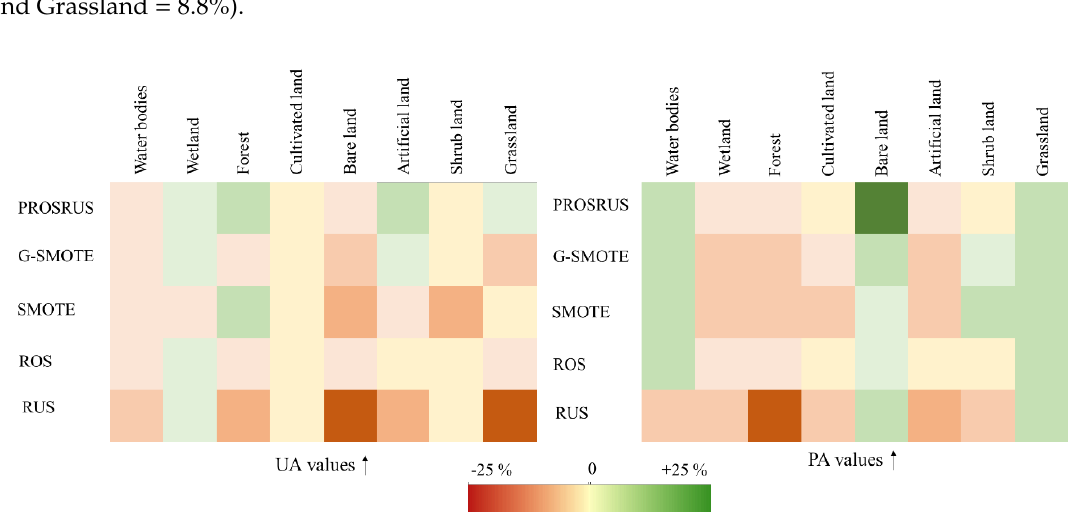
Figure 10. Accuracy assessment of the five resampling methods and the Scenario-4 classification method (i.e., RF with imbalanced samples) over Site-3. Applying PROSRUS-74 led to an increase in the UA values for four classes (out of eight), including Grassland, Bare land, Forest, and Artificial land classes by 5%, 1.3%, 2.7%, and 6.8%, respectively. However, it decreased the accuracy of the Shrub land ( − 0.4) and Cultivated land ( − 2.2%) classes. RF-G-SMOTE, respectively, increased the UA values for the Forest, Cultivated land, Bare land, and Grassland classes approximately by 2%, 0.1%, 2.1%, and 3.38%. It however decreased the PA values of the other three classes. Regarding PA values, PROSRUS-74 improved the results of five classes compared to the Scenario-4 (Shrub land = 23%, Bare land = 2.4%, Cultivated land = 1.5%, Grassland = 1.5%, and Artificial land = 0.01%) (Figure 11). However, there was a reduction of 1.4% in the PA value of the Forest class using the proposed method.